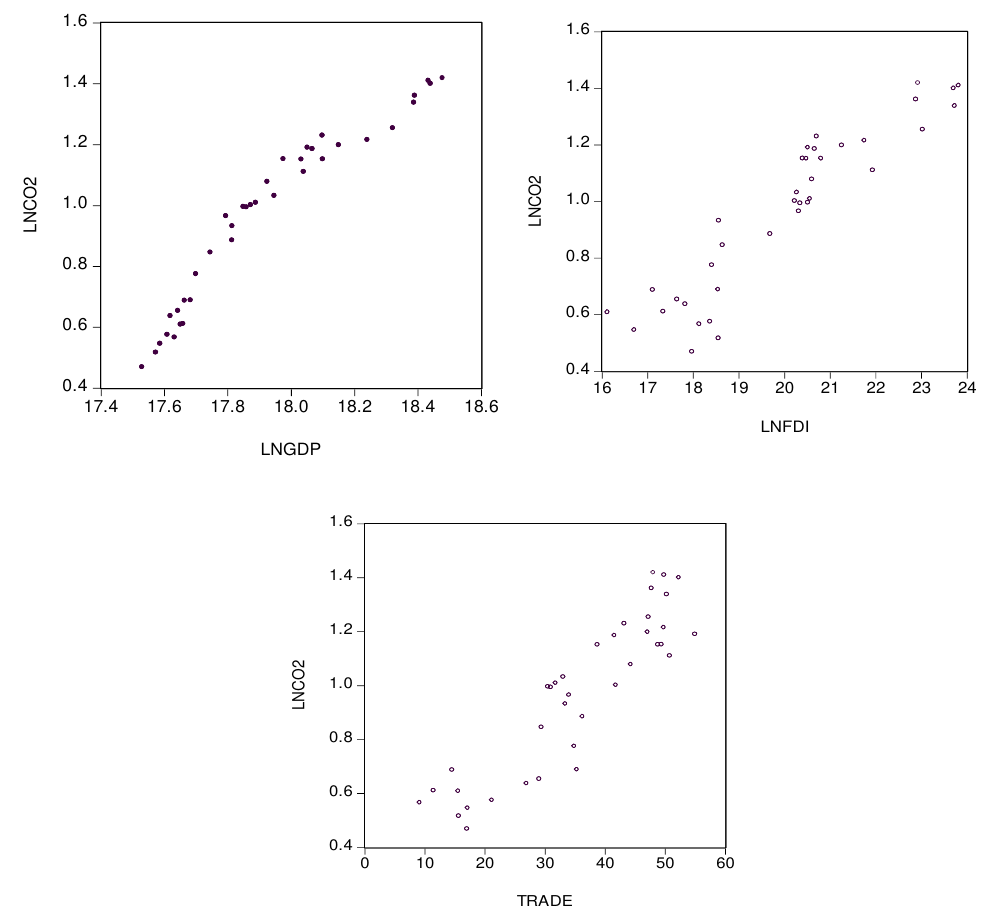
Fig. 1. Scatter plots for ln(CO 2 ) and explanatory